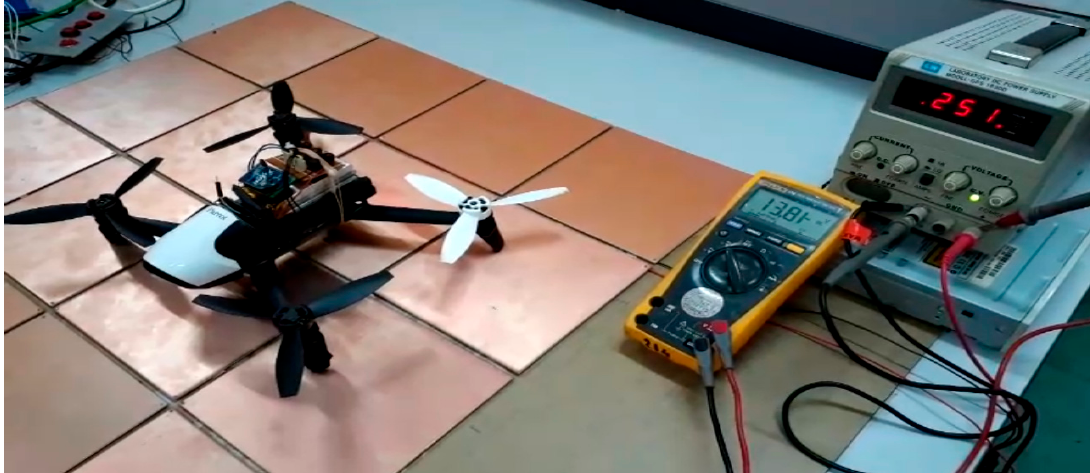
Figure 2. Lab test for the configuration of the chess pad charging platform.